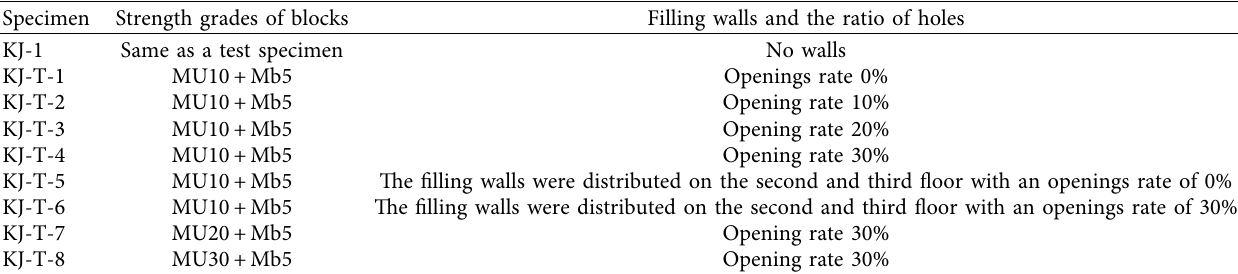
Table 3: Infilled wall